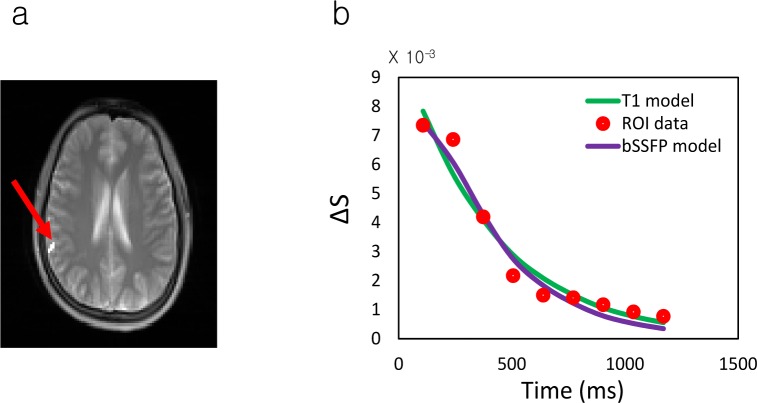
Representative results of fitting to the proposed models.(a) Location of region of interest (ROI) which is drawn manually (red arrow). (b) Dynamic signal difference in the ROI shown in (a) and results of curve fitting with T1 model (green line) and bSSFP model (purple line). The data was acquired with 450% gap and 0-ms inter-slice time delay. ΔS represents signal difference between control and labeling scans.